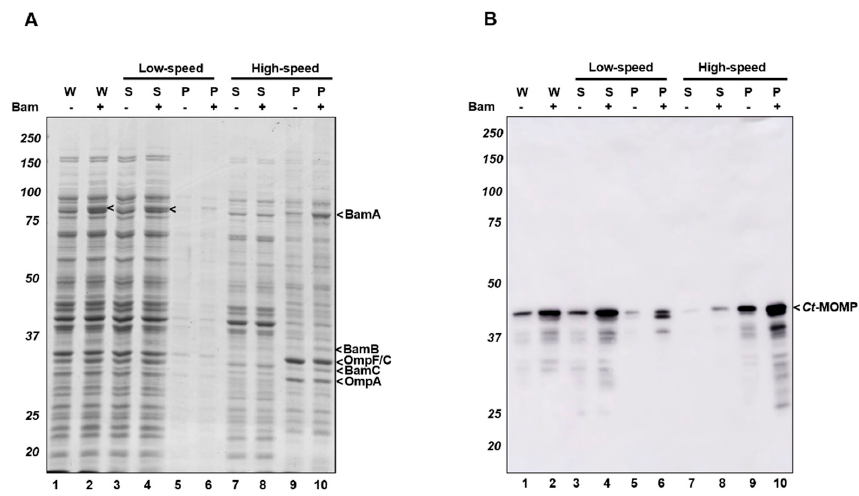
Figure 3. Ct -MOMP localized in the E. coli cell envelopes. Subcellular fractionation of cells co- expressing Ct -MOMP in the presence or absence of the Bam complex. Cells were induced (+) (100 µ M IPTG, 1 h) or not induced ( − ) for expression of the Bam complex followed by induction for expression of Ct -MOMP (8 mM L-rhamnose, 2 h). Samples derived from whole-cell lysates (W) and pellets (P) and supernatants (S) produced by subsequent low-speed and high-speed centrifugation steps were analyzed by SDS-PAGE/Coomassie staining ( A ) or immunoblotting using Ct -MOMP antiserum ( B